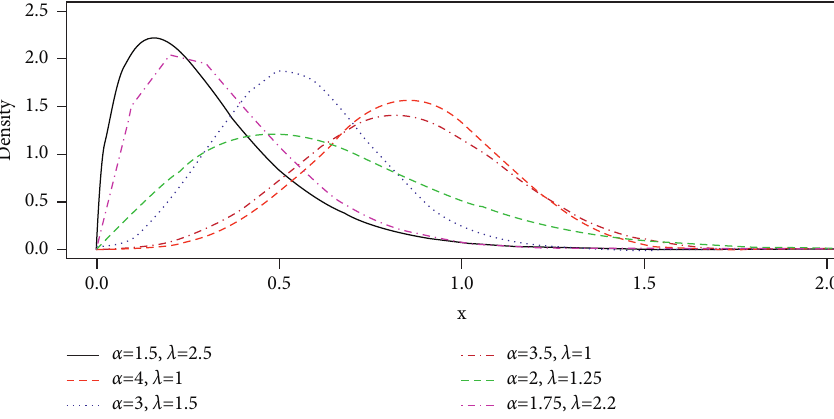
Figure 2: Visual representation of the pdf plots of the AT-W distribution for various parameter values.